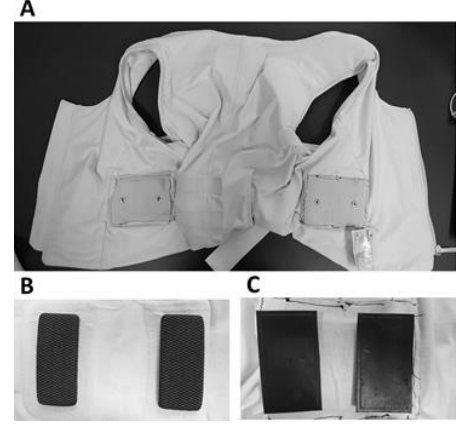
Figure 3. FAV and electrodes. ( A ) The FAV (Philips) modified to include snaps for electrode connections; connections; ( B ) textile electrodes embedded in a Philips vest; and ( C ) carbon black ( B ) textile electrodes embedded in a Philips vest; and ( C ) carbon black polydimethylsiloxane polydimethylsiloxane (CB/PDMS) electrodes. (CB/PDMS)